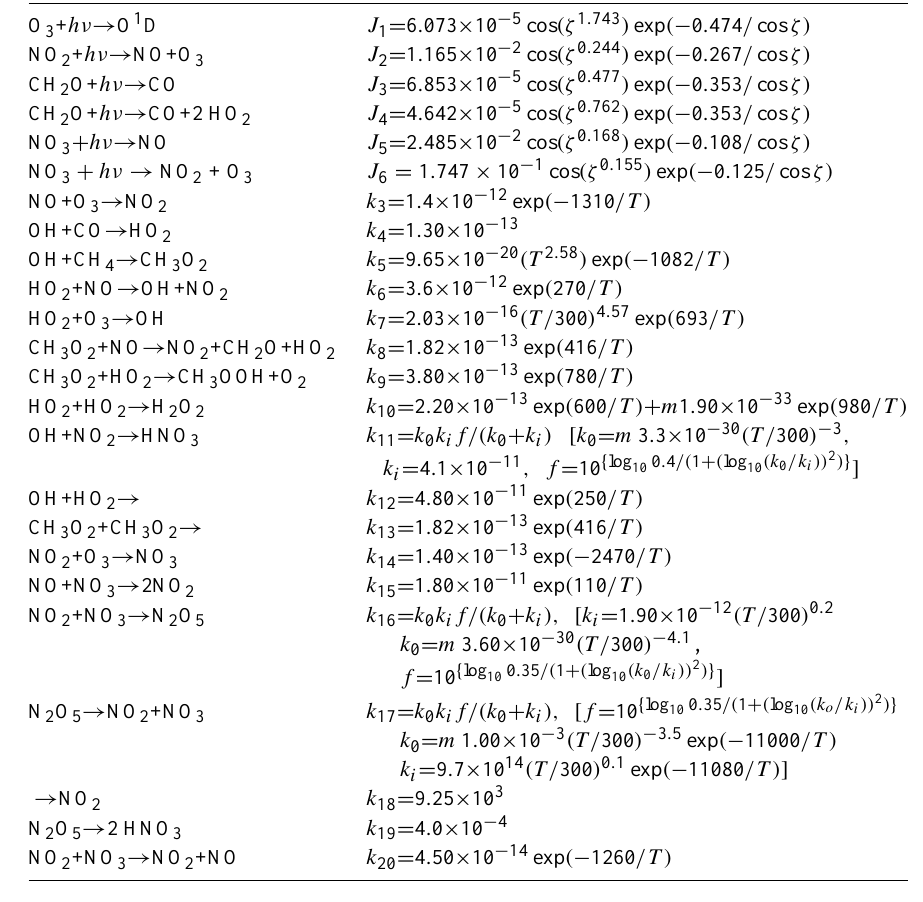
Table 1. Chemical reactions modelled. Derived from the Master Chemical Mechanism where ζ is solar zenith angle; T temperature [K]; p pressure [hPa]; and m number density of air [molecules cm − 3 ]. k 12 reaction product is H 2 O; k 18 represents PAN decomposition; k 19 represents the heterogeneous uptake of N 2 O 5